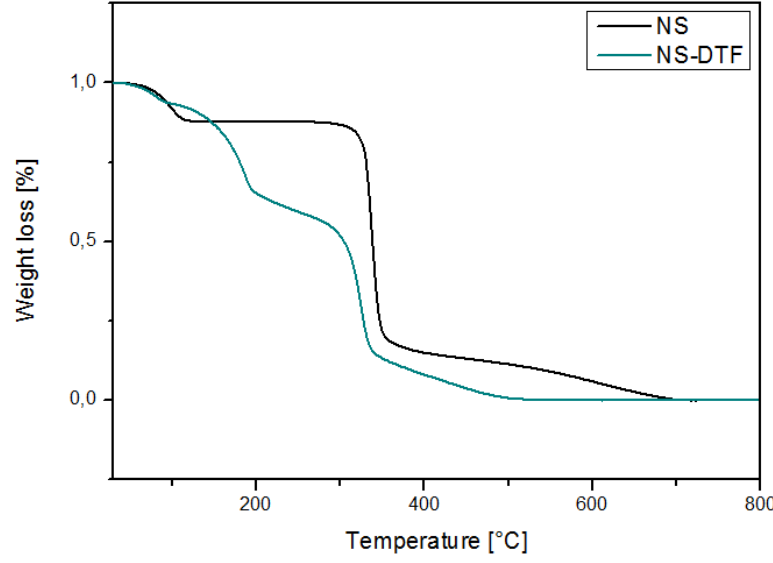
Figure 5. TGA analysis of NS and the NS–DTF complex.